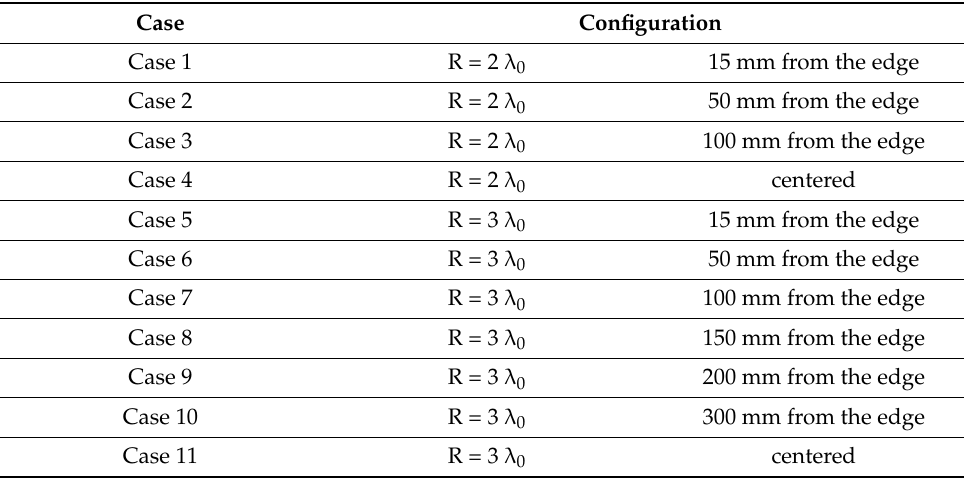
Figure 8. Comparison of TRP s between different antenna mounting configurations. Table 1. Antenna mounting configurations.